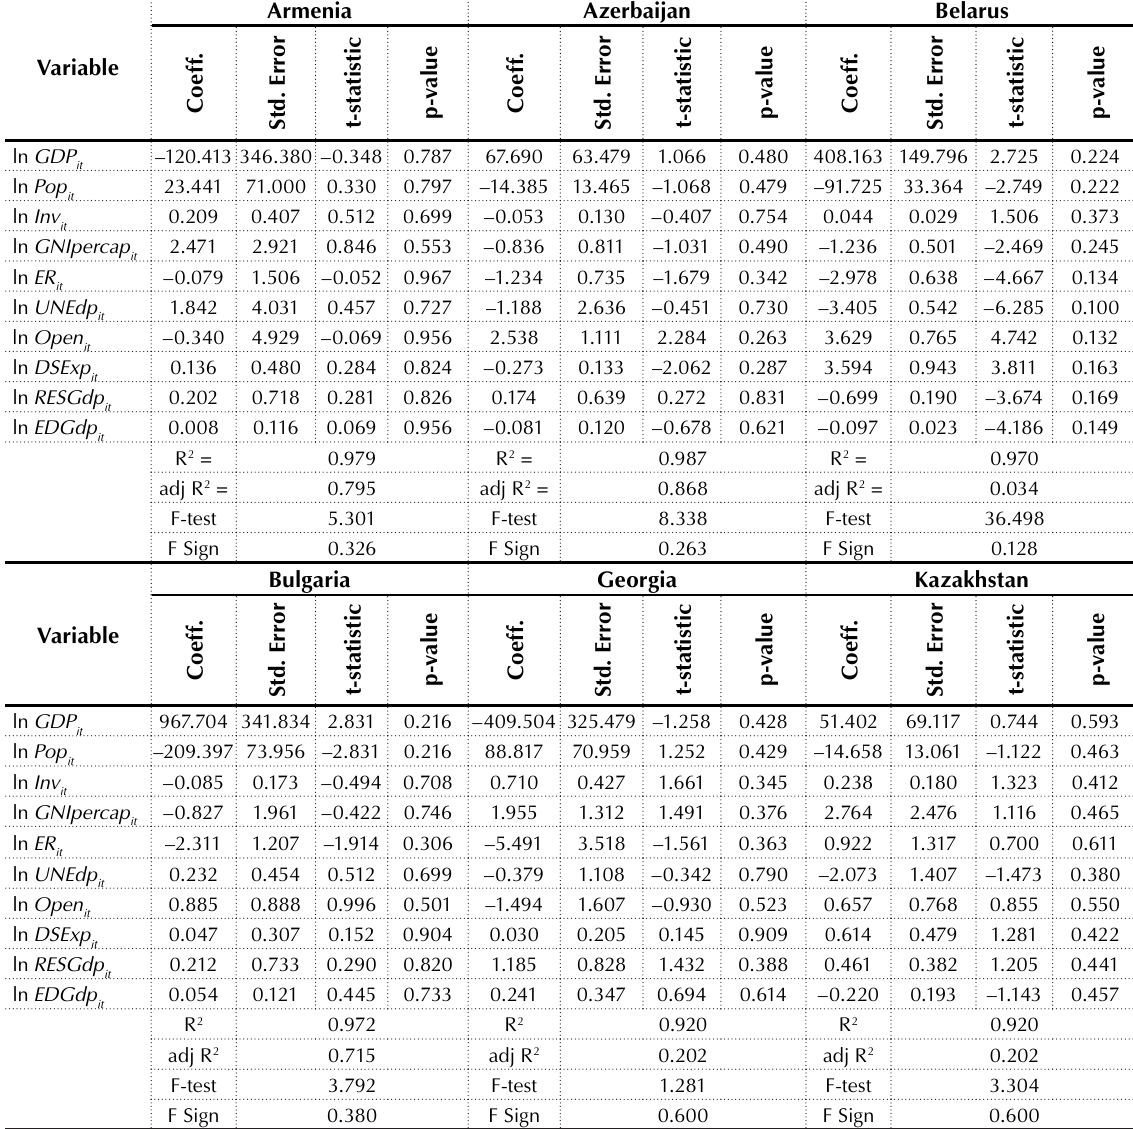
Table A. Fixed effects panel regression for each variable in each country, 2006−2016